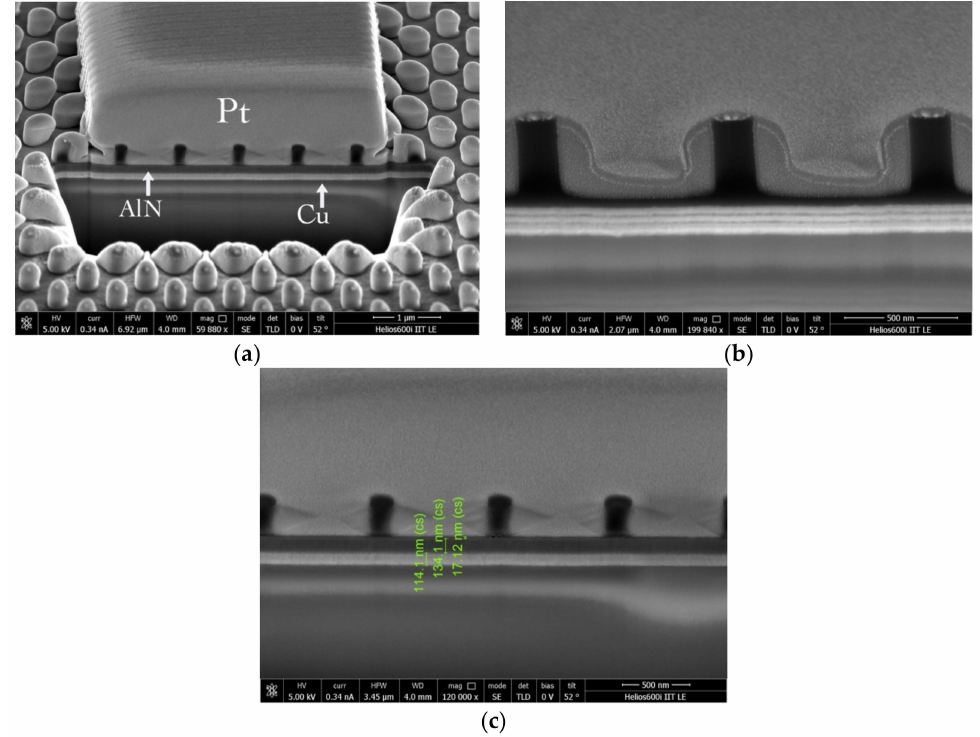
Figure 4. SEM images related to the cross-section of ( a ) bilayer and ( b ) multi-layer designs, respectively. Cu, AlN layers and PMMA pillars ( black region ) while the grey area around pillars is a Pt deposition used to protect the sample while milling with FIB. ( c ) Cross-section of the bilayer sample revealing the PMMA bu ff er layer thickness equal to about 20 nm.